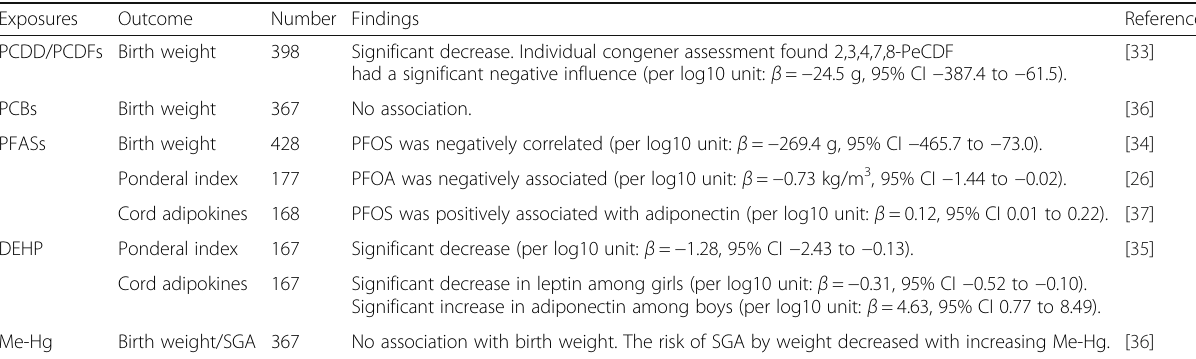
Table 7 Findings from the Sapporo cohort on the associations between exposures and birth size Exposures